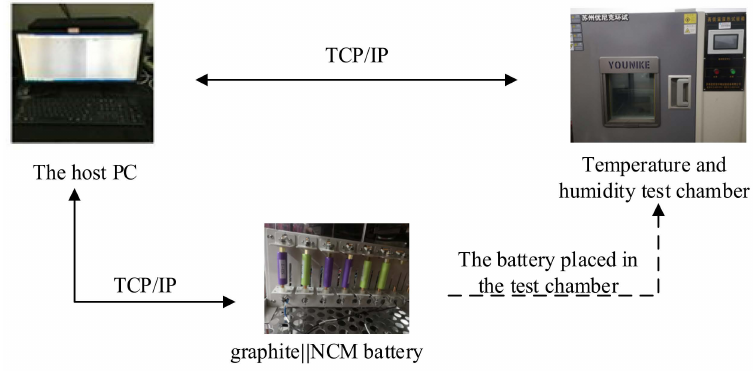
Figure 1. Battery test